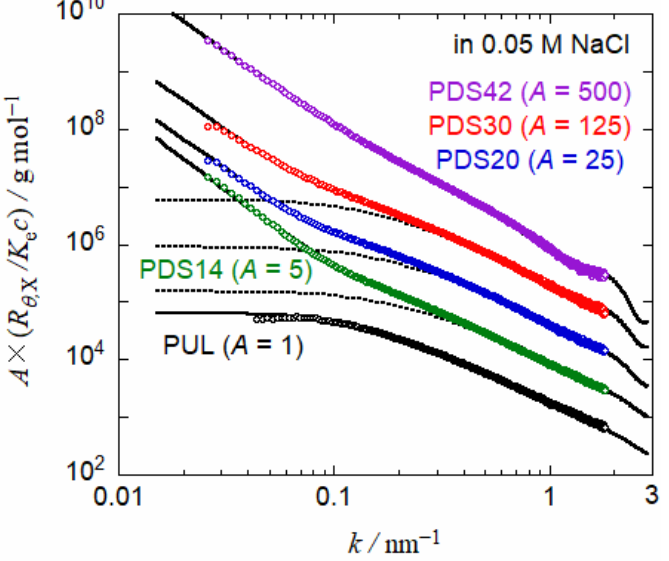
Figure 4. SAXS profiles in 0.05 M aqueous NaCl of PUL and PUL-OSA samples with four different DS . Profiles shifted vertically other than PUL with the shift factor A = 1, 5, 25, 100, 500. Solid curves indicate theoretical values for the loose flower necklace model (see text). The dotted curve indicates theoretical values of theoretical scattering function without aggregating component.